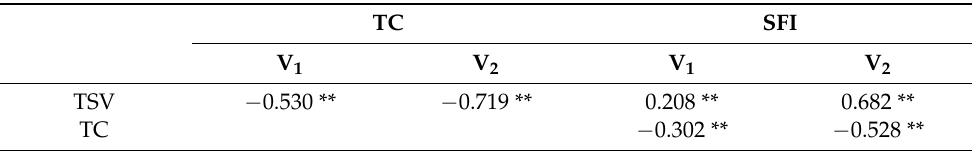
Table 7. Pearson correlation coefficient among subjective perceptions. TC SFI V 1 V 2 V 1 V 2 TSV − 0.530 ** − 0.719 ** 0.208 ** 0.682 ** TC − 0.302 ** − 0.528